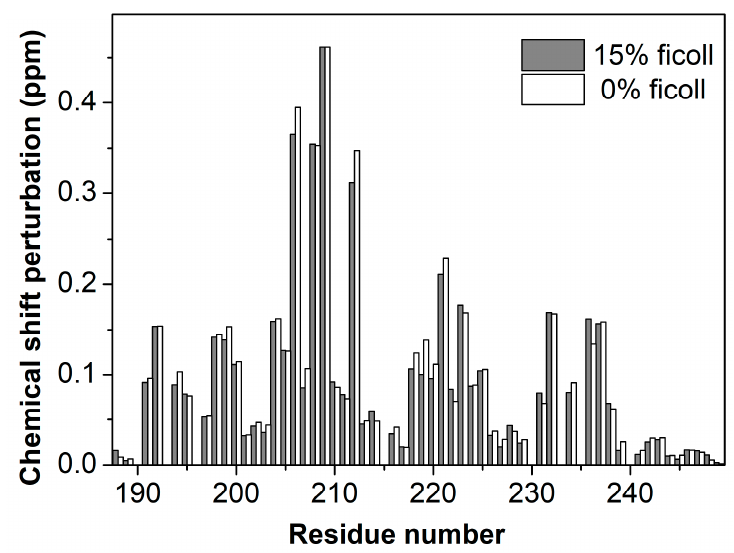
Figure 1. Comparison of Chemical Shift Perturbation (CSP) caused by histone H3 trimethylated at lysine 4 (H3K4me3) peptide binding to ING4- Plant Homeodomain (PHD). The bar plot shows the CSP observed for each residue in 1 H- 15 N HSQC spectra of the PHD in the presence of a four-fold molar excess of H3K4me3 with 15% (grey bars) or 0% (white bars) Ficoll 70. The estimated experimental error is 0.008 ppm.